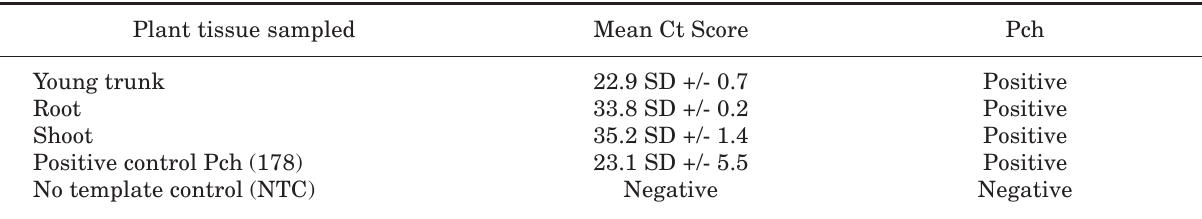
Table 2. Real-time PCR results from trunk cross-sections in which Phaeoacremonium aleophilum (Pal) was isolated. Trunk